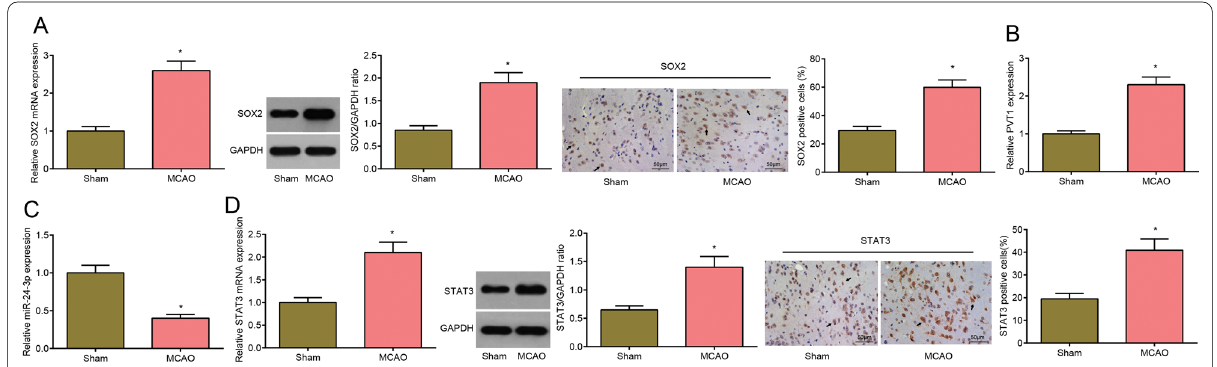
Fig. 1 SOX2, PVT1 and STAT3 are highly expressed while miR-24-3p is poorly expressed in cerebral cortex tissues in MCAO rats. A SOX2 expression in cerebral cortex tissues of MCAO rats ( 200; scale bar 50 μm; arrows indicated positive cells by immunohistochemical staining); B PVT1 × = expression in cerebral cortex tissues of MCAO rats; C miR-24-3p expression in cerebral cortex tissues of MCAO rats; D STAT3 expression in cerebral cortex tissues of MCAO rats ( 200; scale bar 50 μm; arrows indicated positive cells by immunohistochemical staining); n × = * P < 0.05 compared with the sham